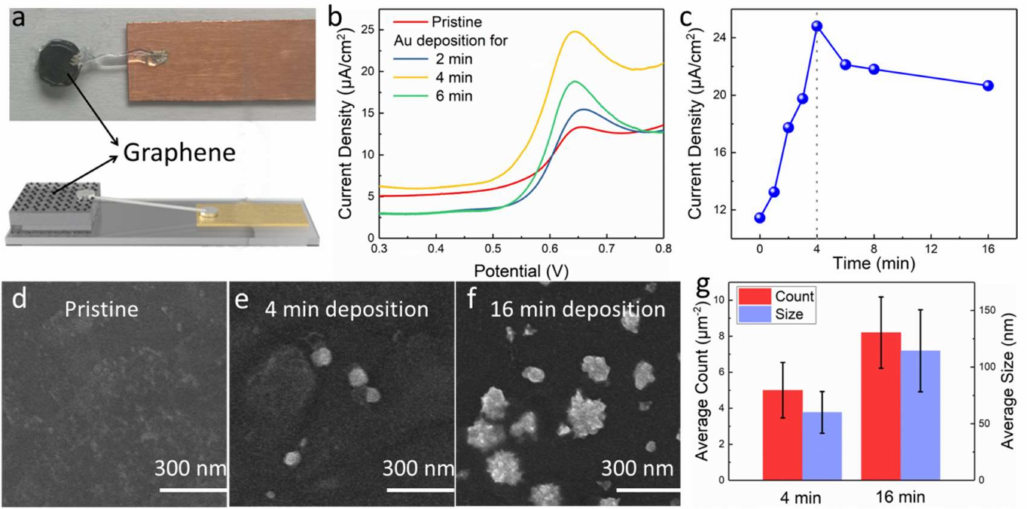
Figure 2. ( a ) Photograph of as-prepared graphene-diamond hybrid electrode. ( b ) CV responses of the electrodes with different deposition periods of AuNPs in PBS containing 50 µ M vanillin (scan rate: 100 mV/s). ( c ) The changes of peak current density of prepared electrodes with different deposition periods. SEM images of ( d ) pristine graphene and AuNP/graphene after ( e ) 4 and ( f ) 16 min of electrodeposition. ( g ) The average count and size of